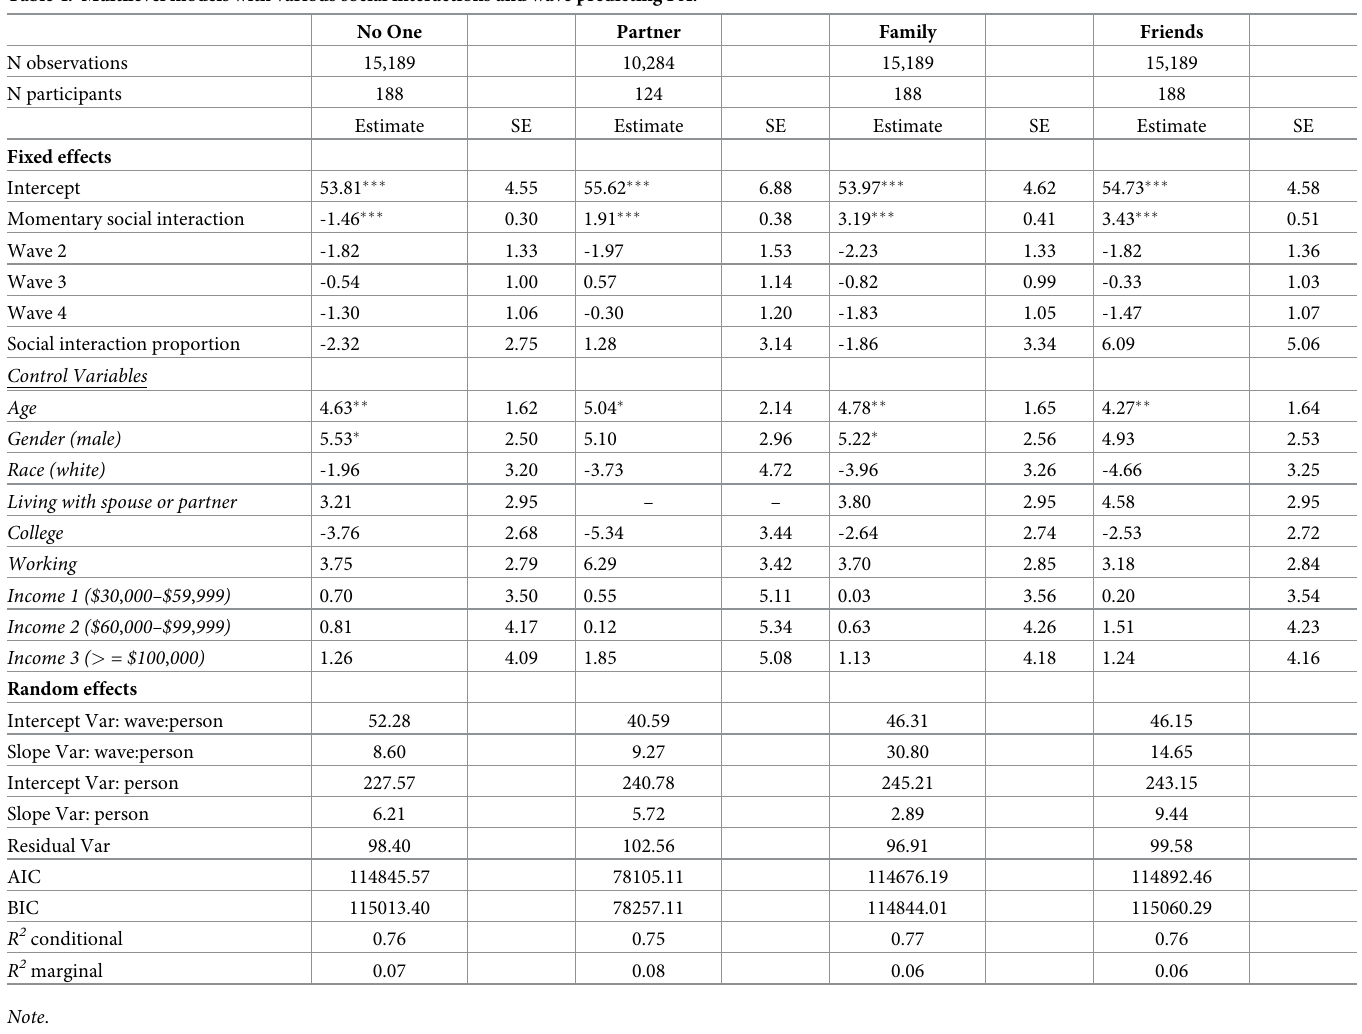
Table 4. Multilevel models with various social interactions and wave predicting